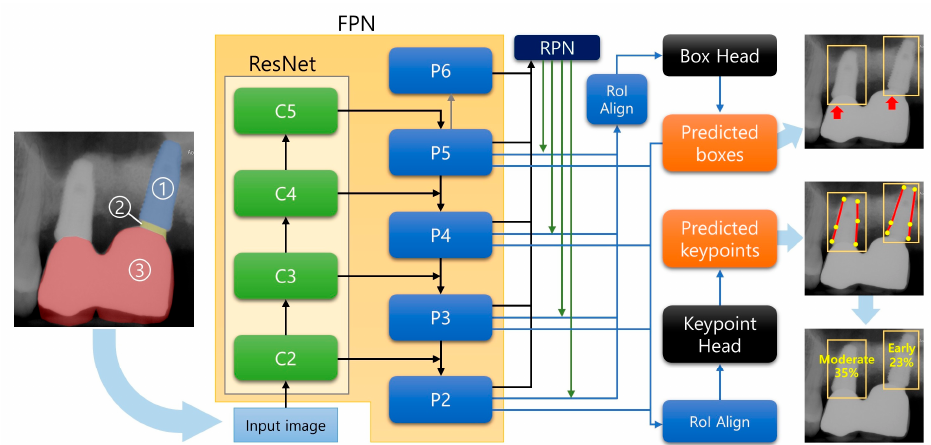
Figure 2. Architecture of the model used in this study. The region proposal network (RPN) takes feature maps from the feature pyramid network (FPN) and proposes region of interest (RoI). The box head further refines the proposals and predicts final bounding boxes (red arrows). In addition, the keypoint head localizes the keypoints (yellow dots shown in the middle of the radiographs on the right) based on the predicted bounding boxes. C2-5 and P2-6 denotes the output feature maps of residual network (ResNet) and FPN, respectively. The upper and lower classification phase is not shown for brevity. Implant ( ① ), Abutment ( ② ) and Superstructure ( ③ ) are shown in the left radiograph. Abbreviations: FPN, Feature Pyramid Network; ResNet, Residual Network; RPN, Region Proposal Network; RoI, Region of Interest.